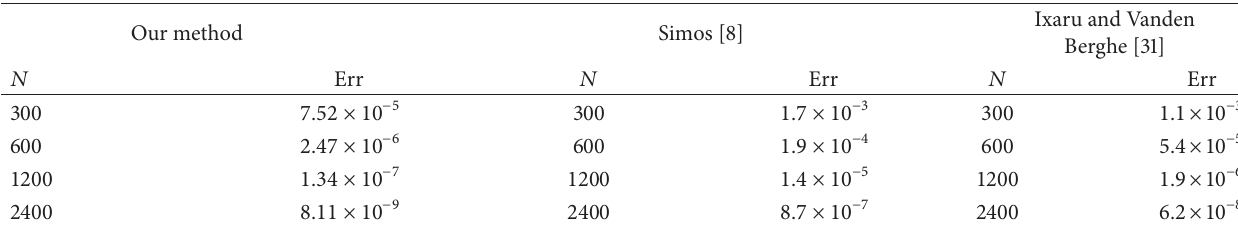
Table 2: Results, with 𝜔 = 1.01 , for Example 2.